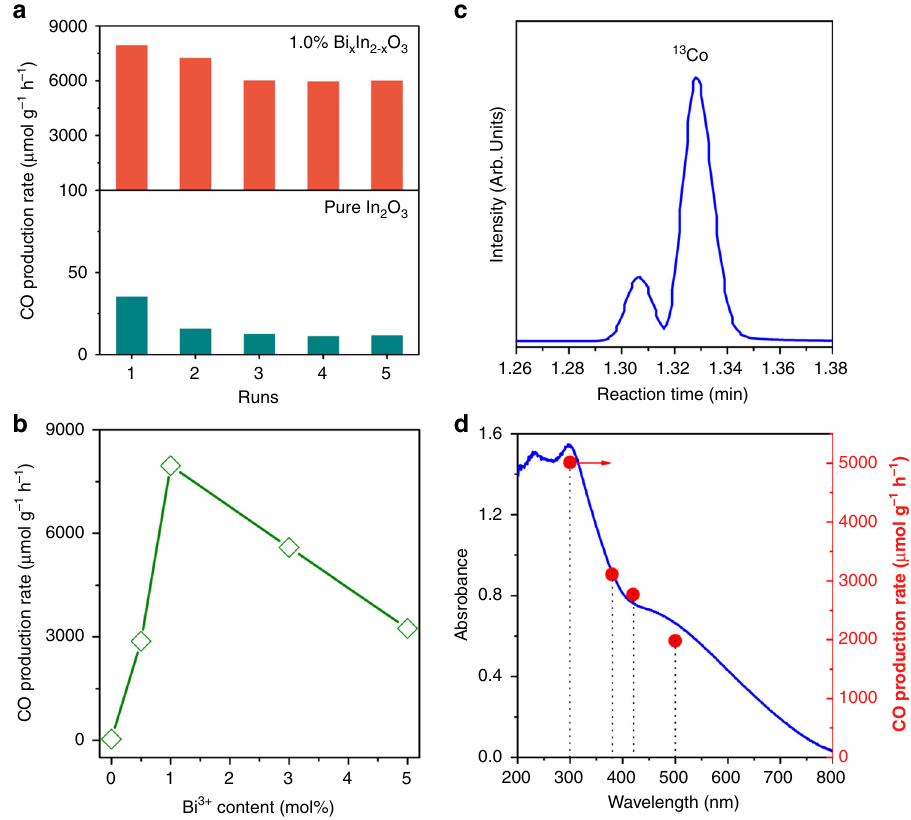
Fig. 2 Photocatalytic performance in the batch reactor. a CO rate of pristine In 2 O 3 (down) and 1.0% Bi x In 2 – x O 3 nanocrystals (up) in catalyzing hydrogenation of CO 2 under illumination. b CO rate as a function of Bi 3 + content for various Bi x In 2 – x O 3 nanocrystals. c GC-MS plot of 13 CO produced from 13 CO 2 over 1.0% Bi x In 2 – x O 3 nanocrystals. d CO rate as a function of absorption cutoff